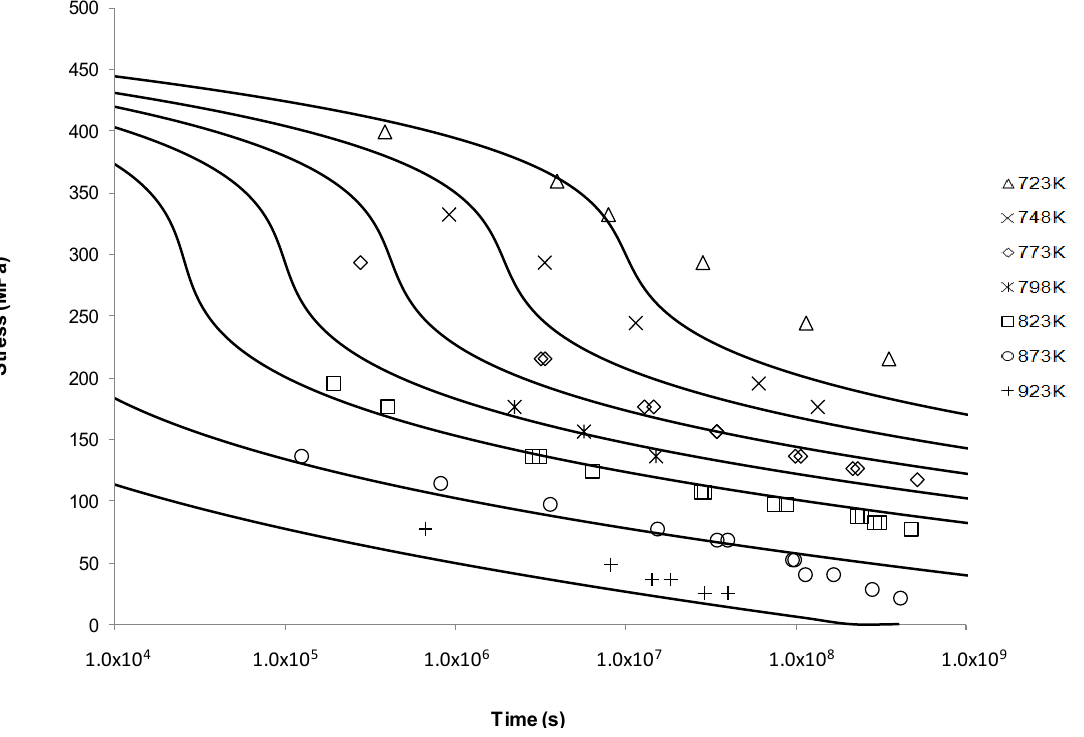
Figure 6. The Goldhoff-Sherby’s stress vs . time to fracture predictive curves using Grade 22 Steel creep data.